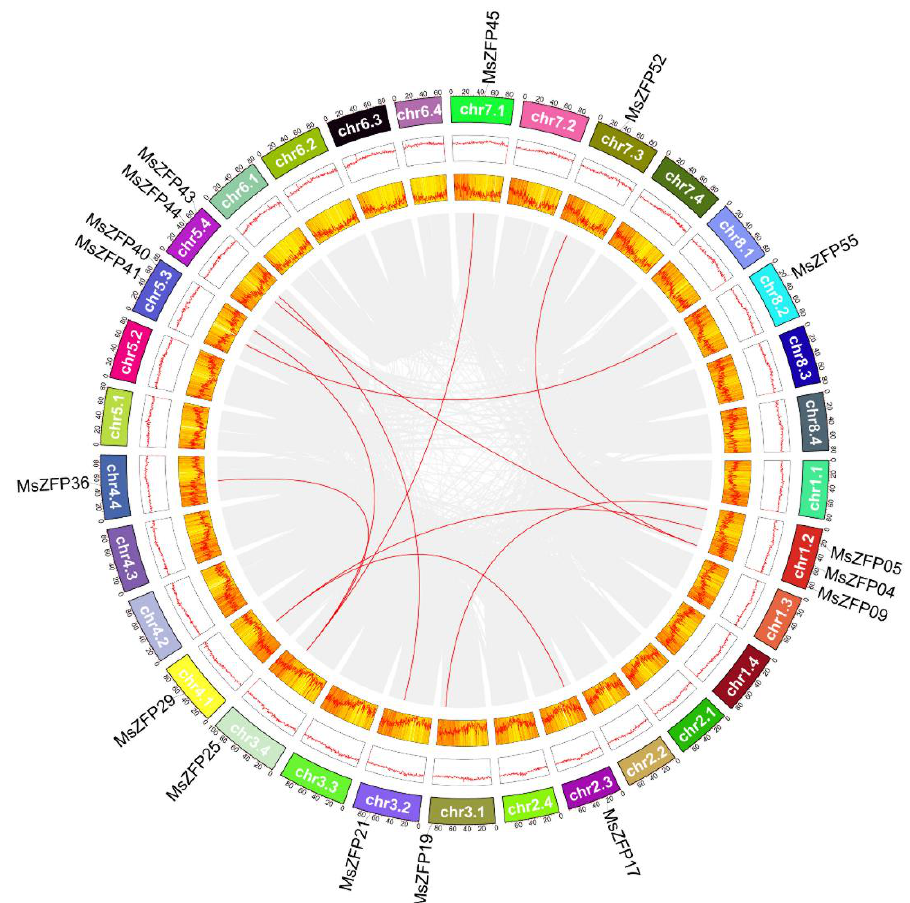
Figure 4. Synteny analysis of MsZFP genes in alfalfa. Grey lines represent all synteny blocks in the alfalfa genome. Red lines indicate the duplicated MsZFP gene pairs in alfalfa. Yellow and red boxes indicate the gene density and GC content of all genes in alfalfa, respectively.